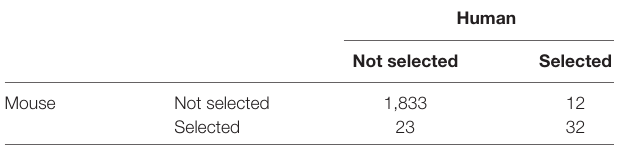
vectors selected among all 1,977 singular value vectors, u , attributed to human ℓ j cells and 44 singular value vectors selected among all 1907 singular value vectors, v , attributed to mouse cells. ℓ k Human Not selected Selected Mouse Not selected 1,833 12 Selected 23 32 Selected: corrected P-values, computed with regression analysis [Eqs. (6) and (7)], are less than 0.01. Not selected: otherwise. Odds ratio is as many as 227, and P-values computed by Fisher’s exact test are 1.44×10 -44